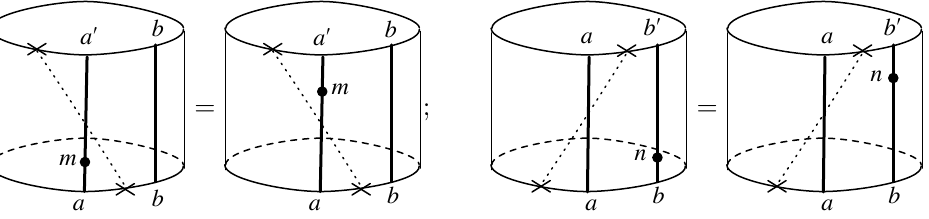
Figure 39 . Morphisms can be crossed across the auxiliary line.